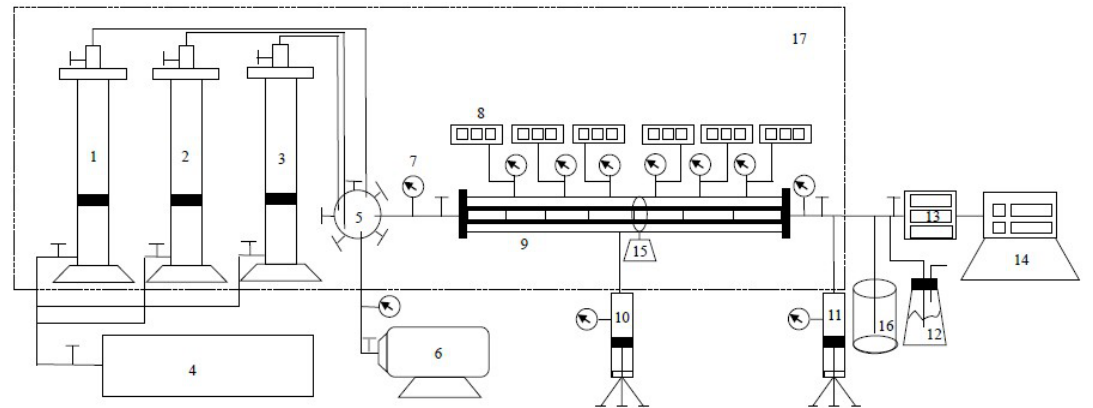
Figure 1. Schematic diagram of the experimental setup (1. Intermediate container (high purity CH 4 ),